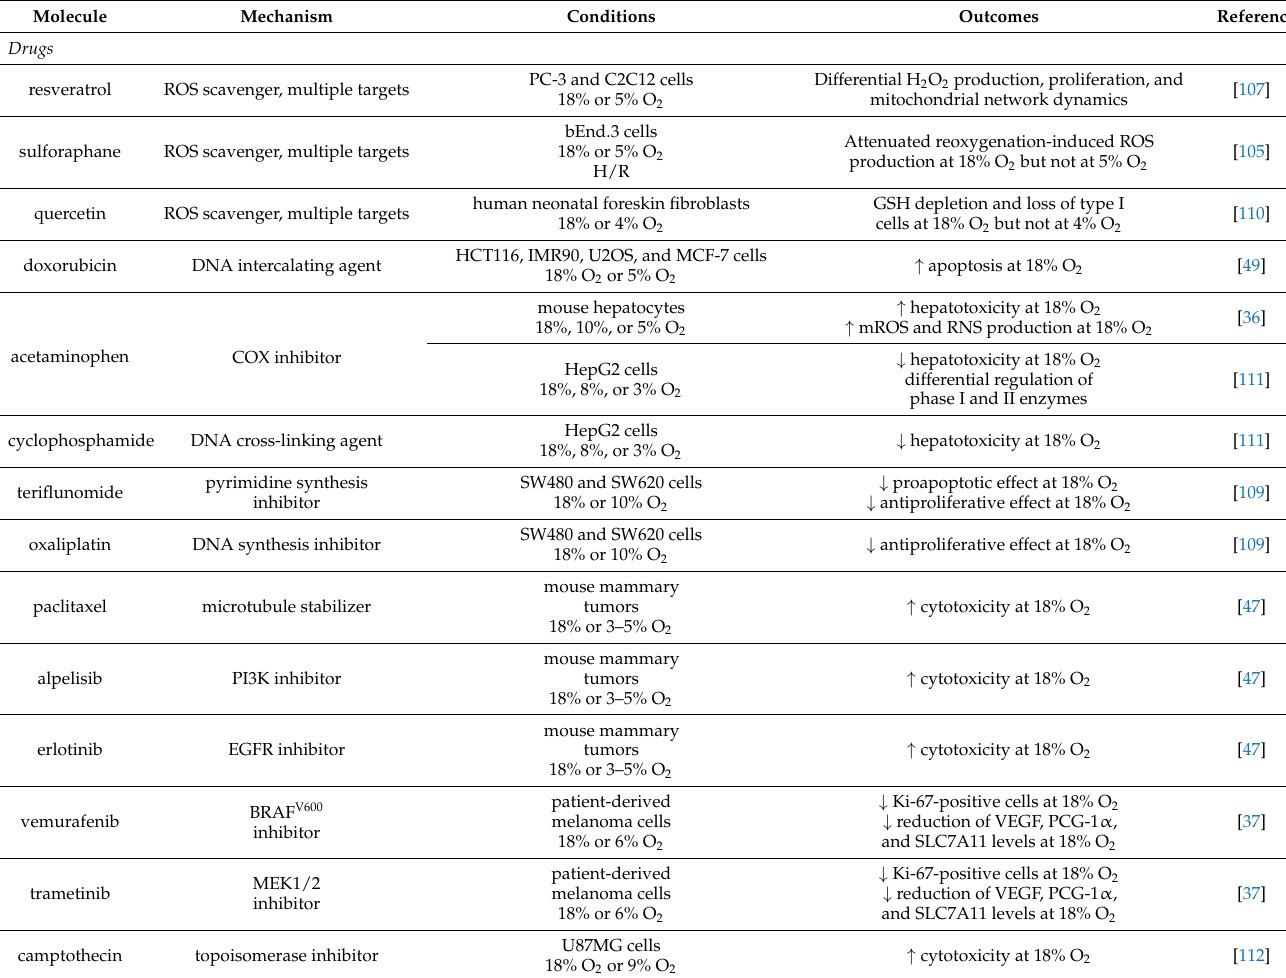
Table 2. Differential cellular responses to drugs, hormones, and toxicants at atmospheric O 2 versus